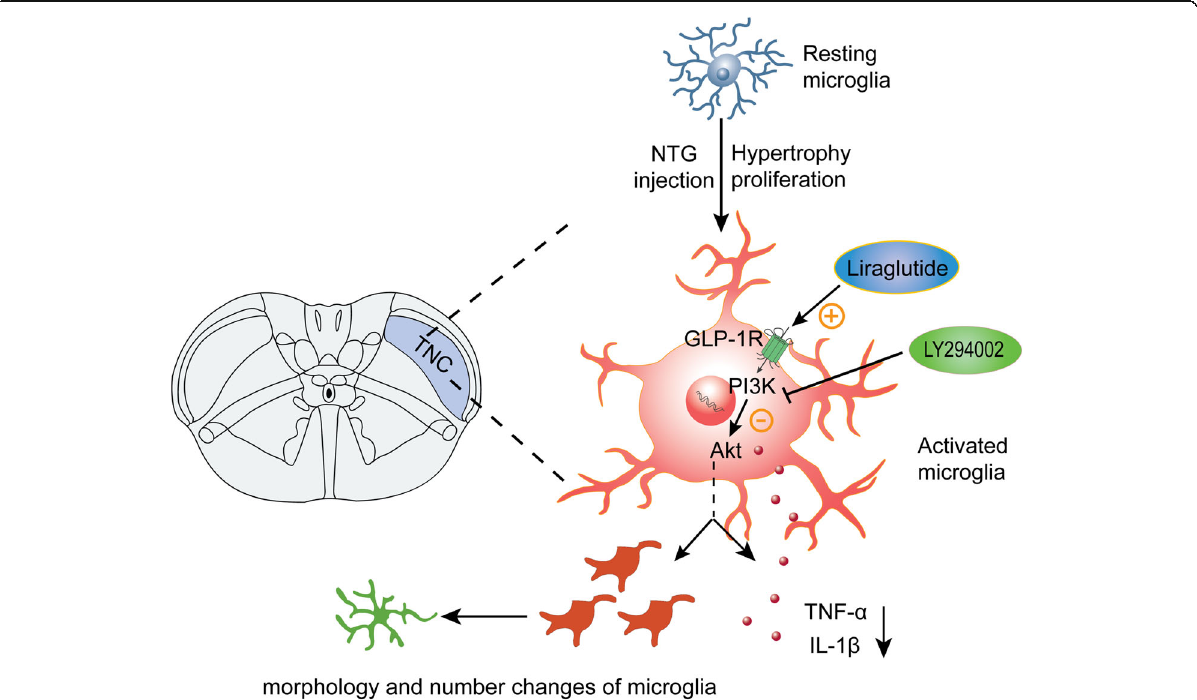
Fig. 9 Schematic of the potential mechanisms of GLP-1R in the TNC in the CM animal model. After repeated NTG administration, microglia in the TNC are activated, and GLP-1R expressed on microglia is dramatically upregulated. Activation of GLP-1R inhibits the function of the downstream PI3K/Akt pathway, thereby inhibiting microglial cell proliferation, morphological changes (shortening of the processes), and inflammatory cytokine (IL-1 β and TNF- α ) production and ultimately alleviating the central sensitization of